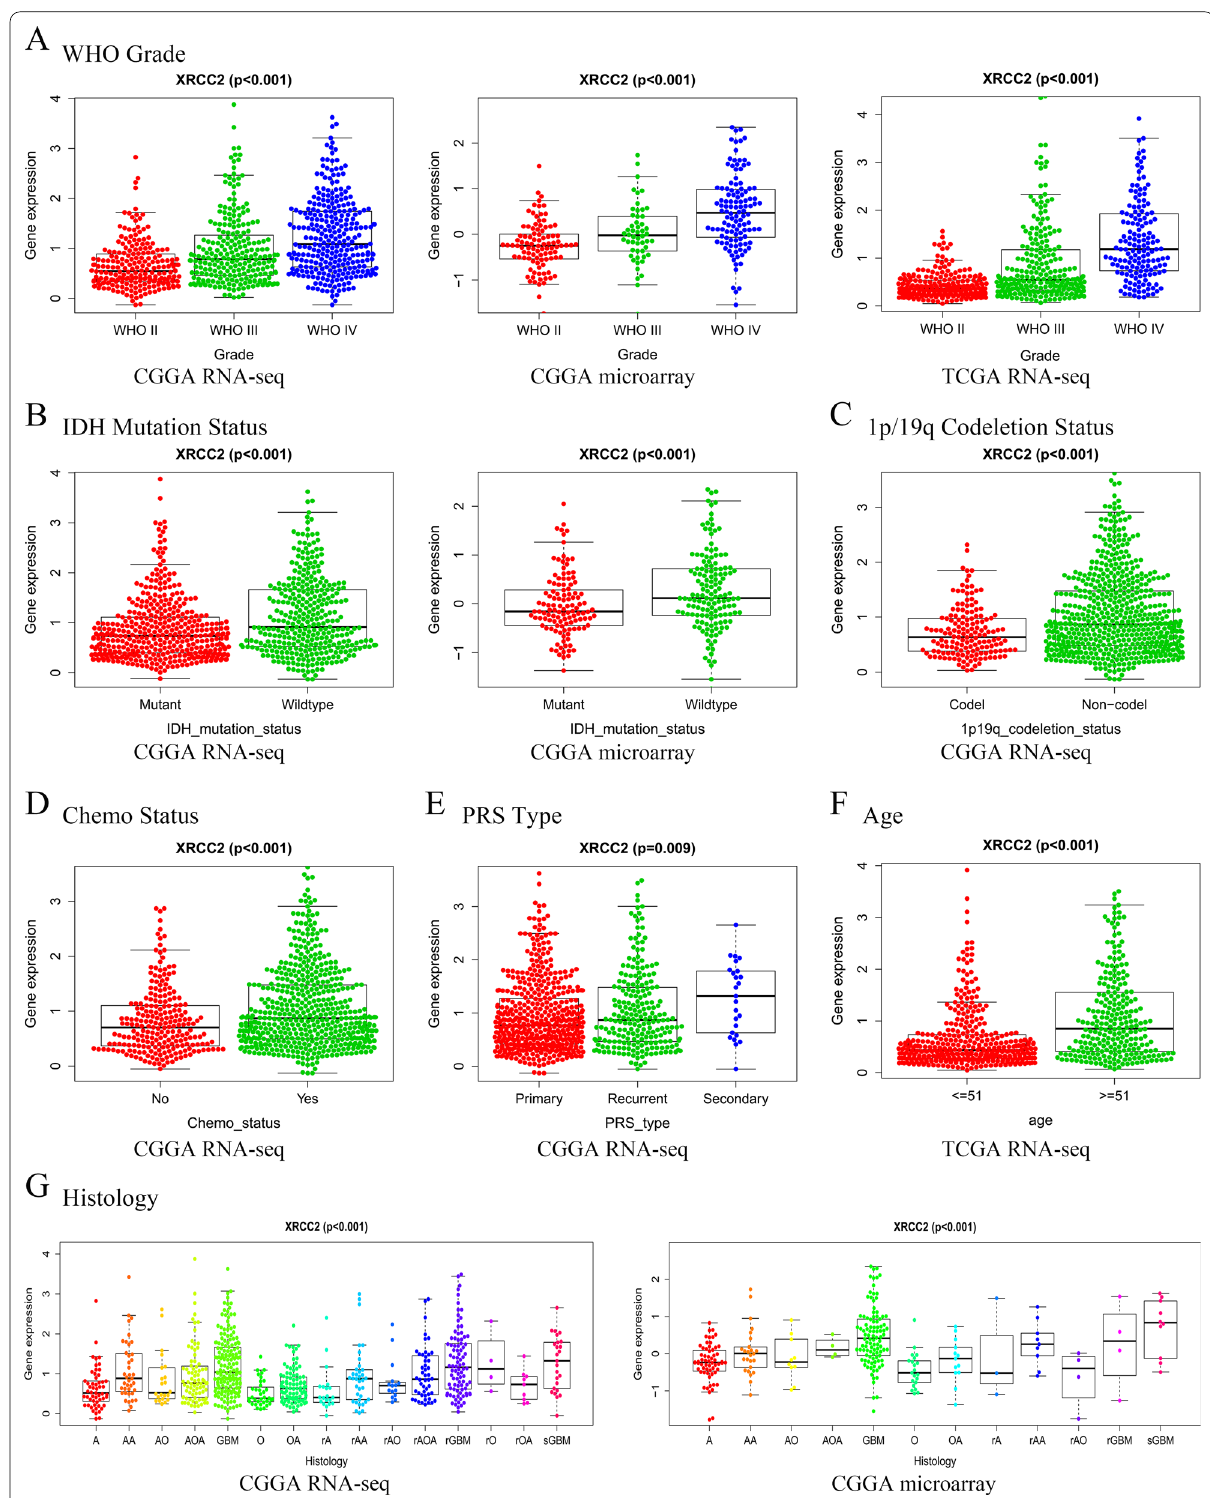
Fig. 4 Correlation between high XRCC2 expression and different clinical features of glioma. A Grade; B IDH mutation presence; C 1p/19q co-deletion presence; D Chemo status; E PRS Type; F Age; G Histology. PRS primary recurrence and